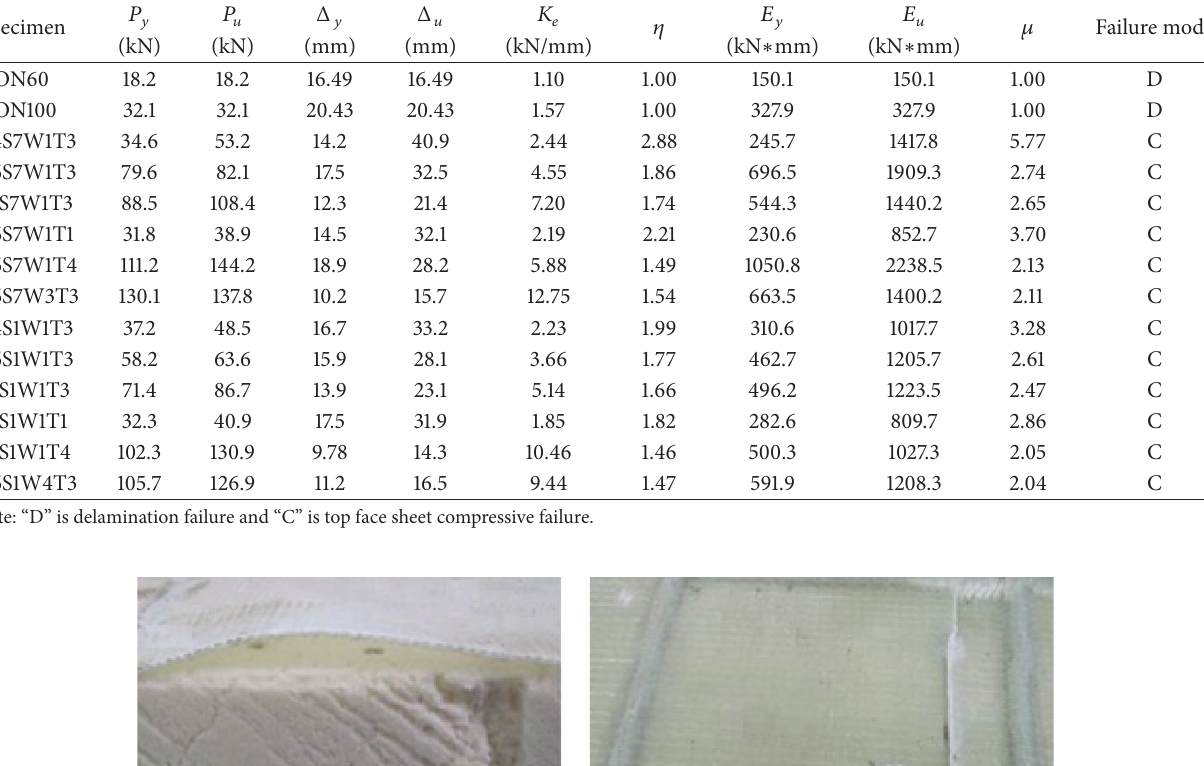
Table 4: Two-way bending test results.